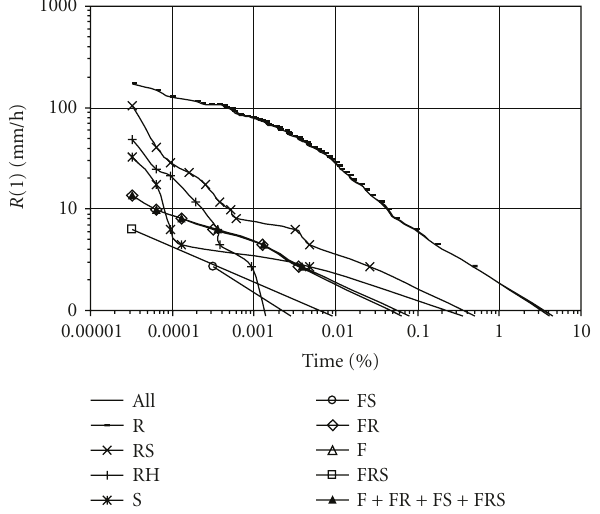
Figure 8: Obtained CDs of the average 1-minute rain intensities for all the hydrometeors combined as well as for the individual hydrometeors.